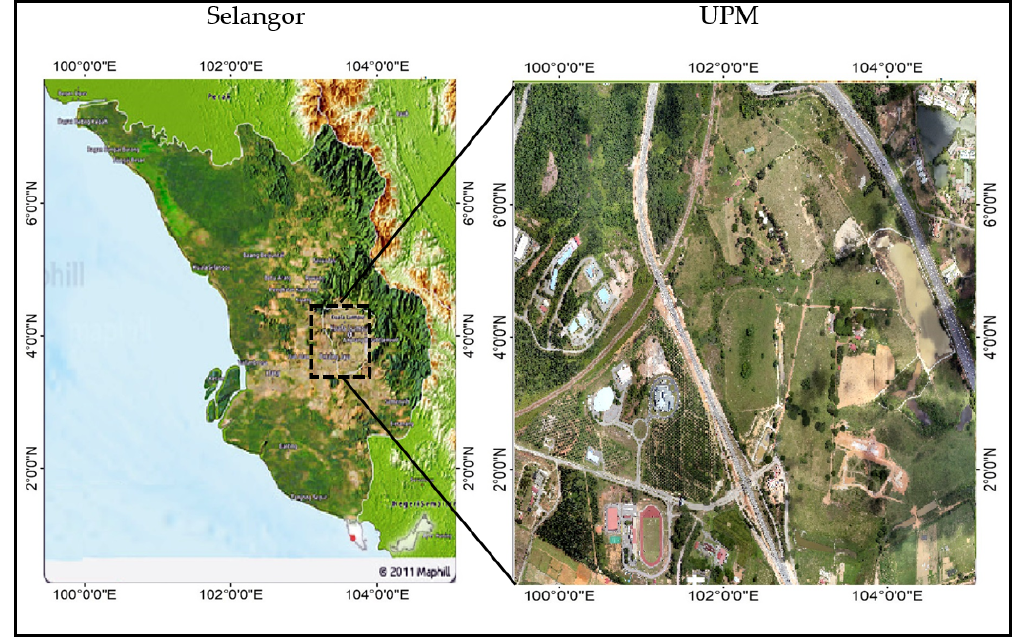
Geosciences 2023 , 13 , x FOR PEER REVIEW Figure 1. Location map of Selangor ( left ) and location of the study area in UPM, Serdang ( right ).